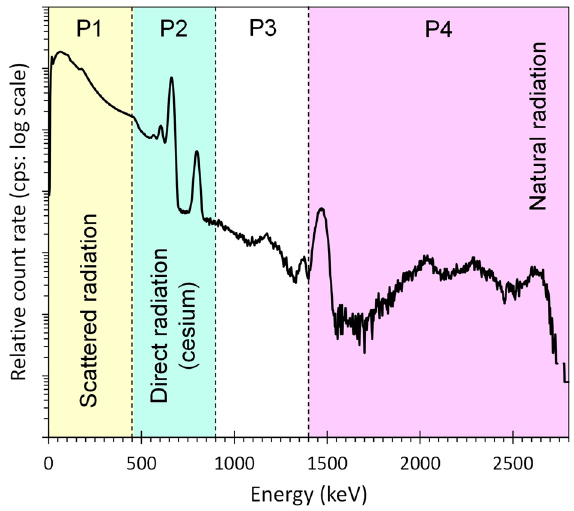
Figure 3. Typical gamma-ray spectrum of a UAV spectrometer with a LaBr3 (Ce) sensor. This spectrum was obtained at 50 m agl. around the FDNPP.